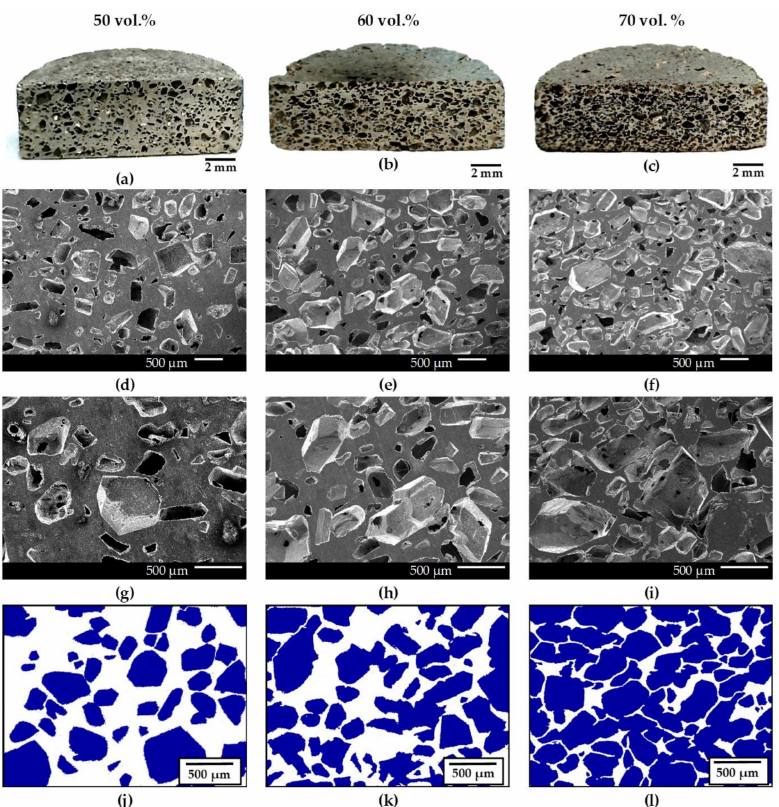
Figure 7. ( a – c ) Macrographs; SEM micrographs ( d – f ) × 30 ( g – i ) × 50; ( j – l ) Image Analysis micrographs. Al foams with design porosities of ( a , d , g , j ) 50 vol.%, ( b , e , h , k ) 60 vol.% and ( c , f , i , l ) 70 vol.%. The pores have a prismatic geometry and sizes between 500 and 1000 µ m, which corresponds with the original shape and size of the saccharose crystals used (Figure